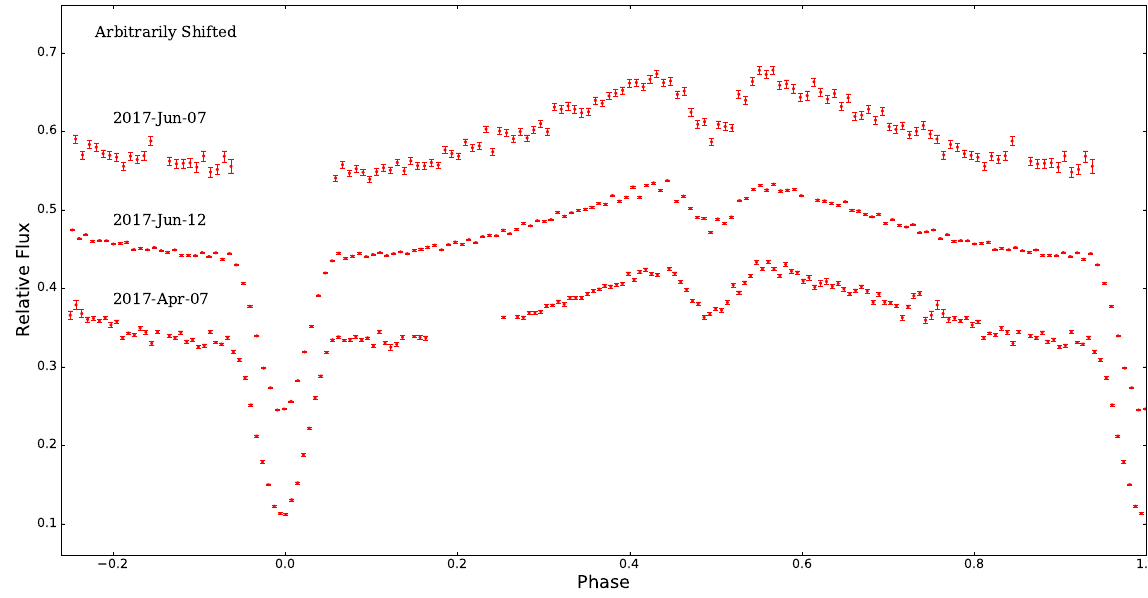
Figure 1. T100 Light Curves of NY Vir (in R c band) with respect to orbital phase, shifted arbitrarily in the relative flux.